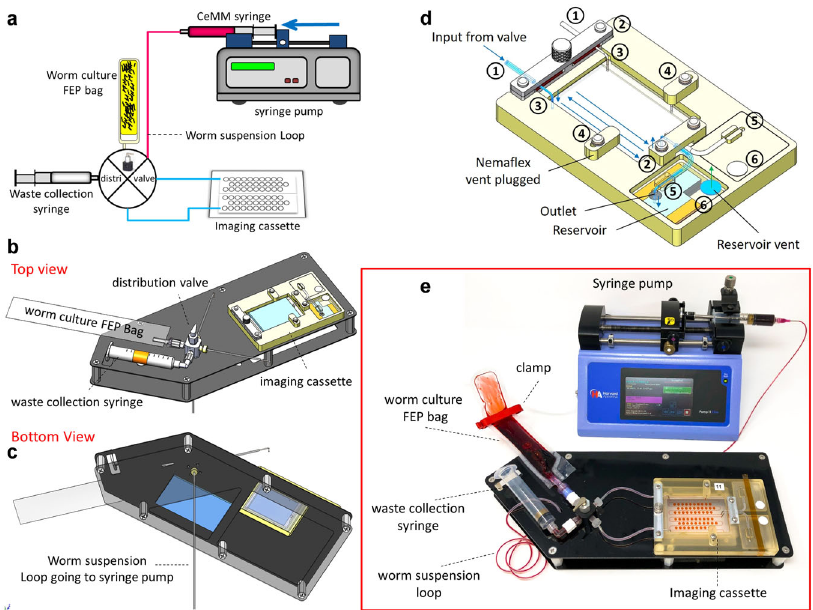
Fig. 4 Micro fl uidics-integrated worm loading apparatus. a Schematic diagram of the worm loading apparatus ( b ) and ( c ) shows the schematic top and bottom view of the WLA board and its key component, respectively. d A leak proof imaging cassette for loading the worms into NemaFlex-S Cassette. The highlighted parts are: (1) inlet lines connected to the distribution valve (2) clips holding the inlet and outlet cannulas (3) L-shaped cannulas connected to the inlet of NemaFlex-S chip (4) cannula connected to air-vent purge port (5) outlet cannula opening into the waste collection chamber (6) porous membrane for releasing the air. e Image of the actual worm loading apparatus showing the three major hardware components – Imaging cassette, distribution valve, and the syringe pump. The worm culture bag and 10 mL waste collection syringe are connected to the distribution valve; the worm suspension loop carries either the CeMM from the media syringe or worm solution from the culture bag. The distribution valve has a feeding port (shown in fi g. c ) underneath the mounting board. Image used in this fi gure was captured at